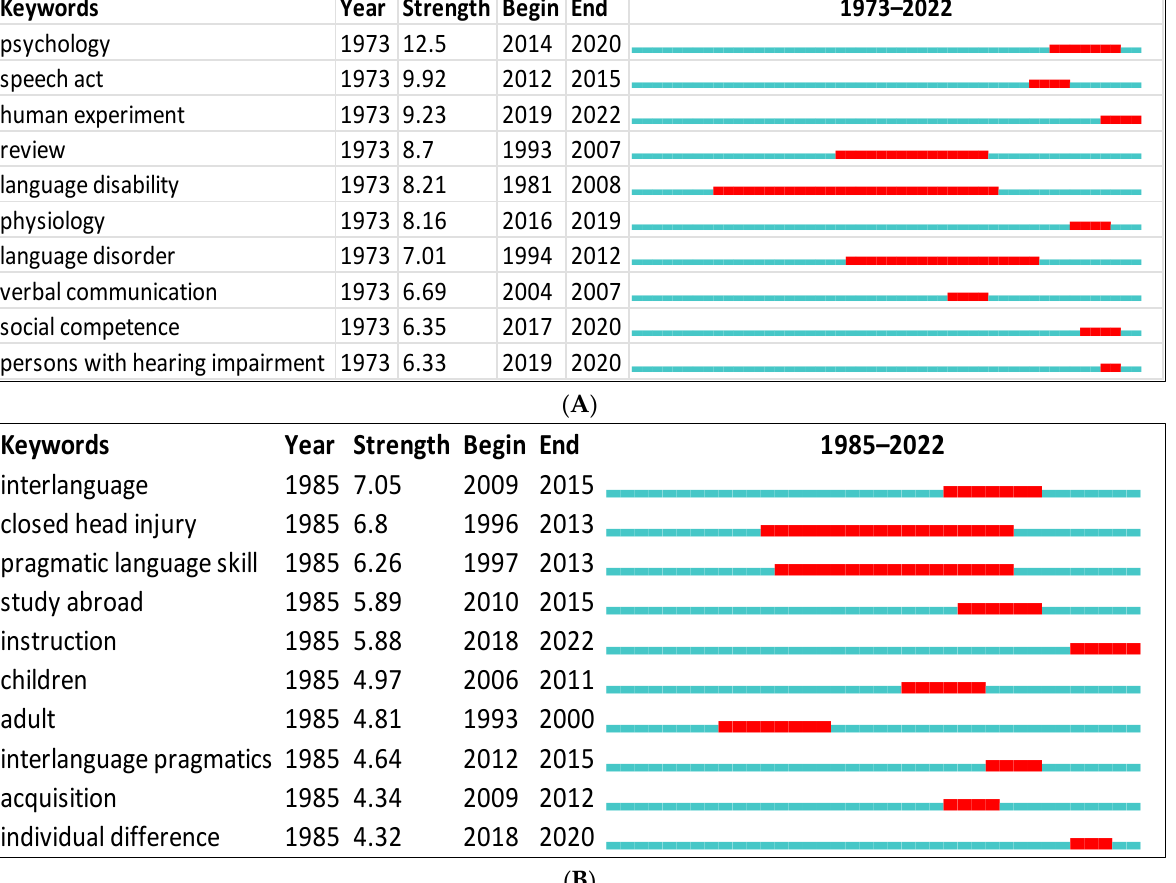
Figure 8. Top 10 keywords with the strongest citation bursts: ( A ) Scopus; ( B ) WOS.